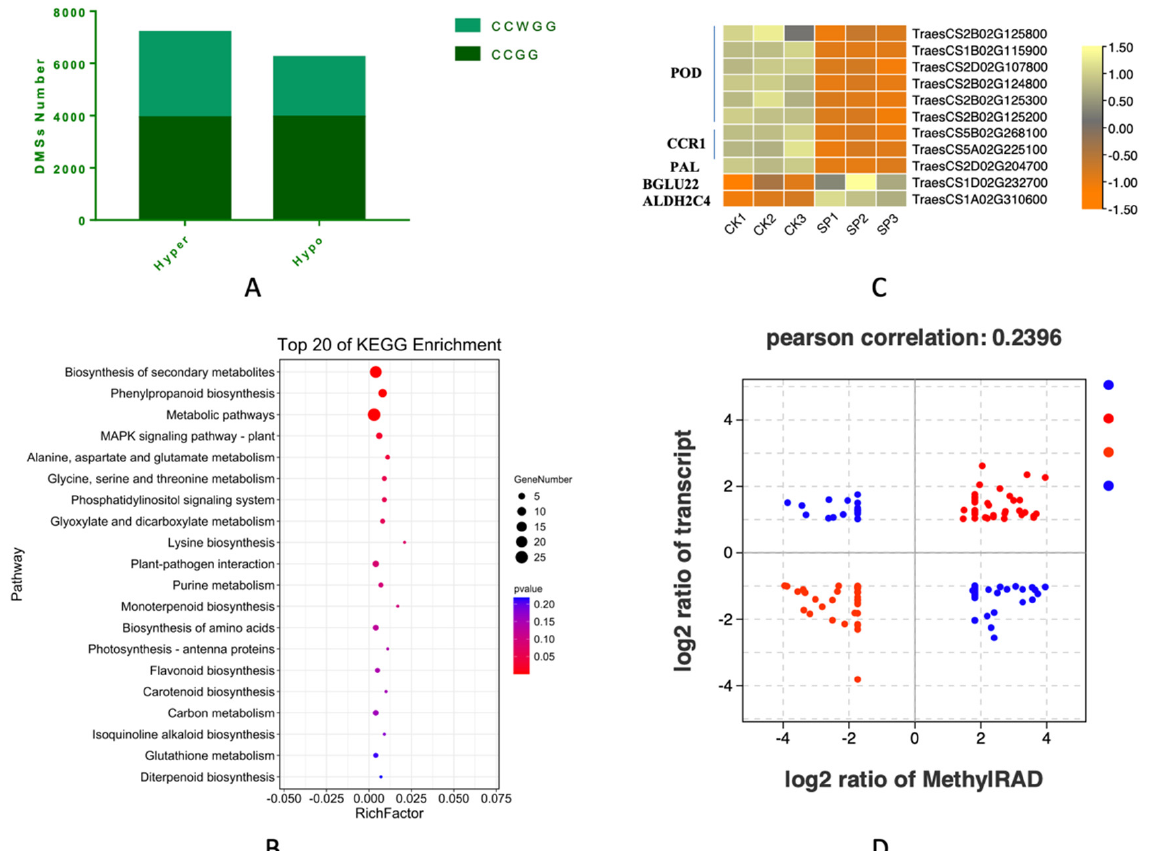
Figure 9. The integrated analysis of DMSs and DEGs: ( A ). The numbers of DMSs at the CCGG and CCWGG sites. ( B ). KEGG enrichment of the common genes differentially expressed and differentially methylated. ( C ). The expression profiles of the methylation regulated DEGs annotated in the “ phenylpropanoid biosynthesis ” pathway. The relative expression values ranged from –1.5 to 1.5. ( D ). Four-quadrant analysis between DMSs and DEGs. Blue spots represent the genes that are negatively correlated with their DNA methylation levels, while red spots represent genes with a positive correlation. DMSs, Differentially Methylated Sites; KEGG, Kyoto Encyclopedia of Genes and Genome; DEGs, Differentially Expressed Genes.